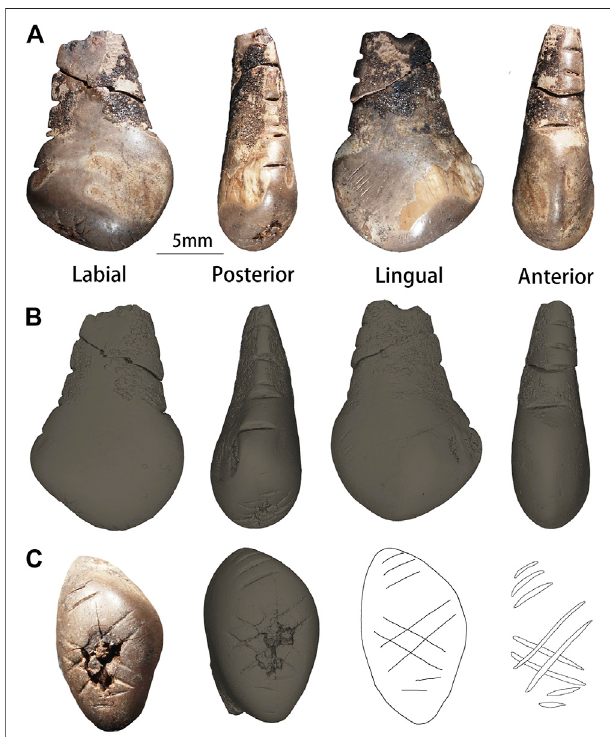
FIGURE 2 | Photographs and µ-CT surface view of the aspects of the QG10 perforated red deer canine. (A) (B) From left to right: the labial, posterior, lingual and anterior aspect [ (A) : photographs; (B) : micro-CT 3D models]; (C) The occlusal aspect (from left to right: photograph, 3D model, and tracings). Scale: 5